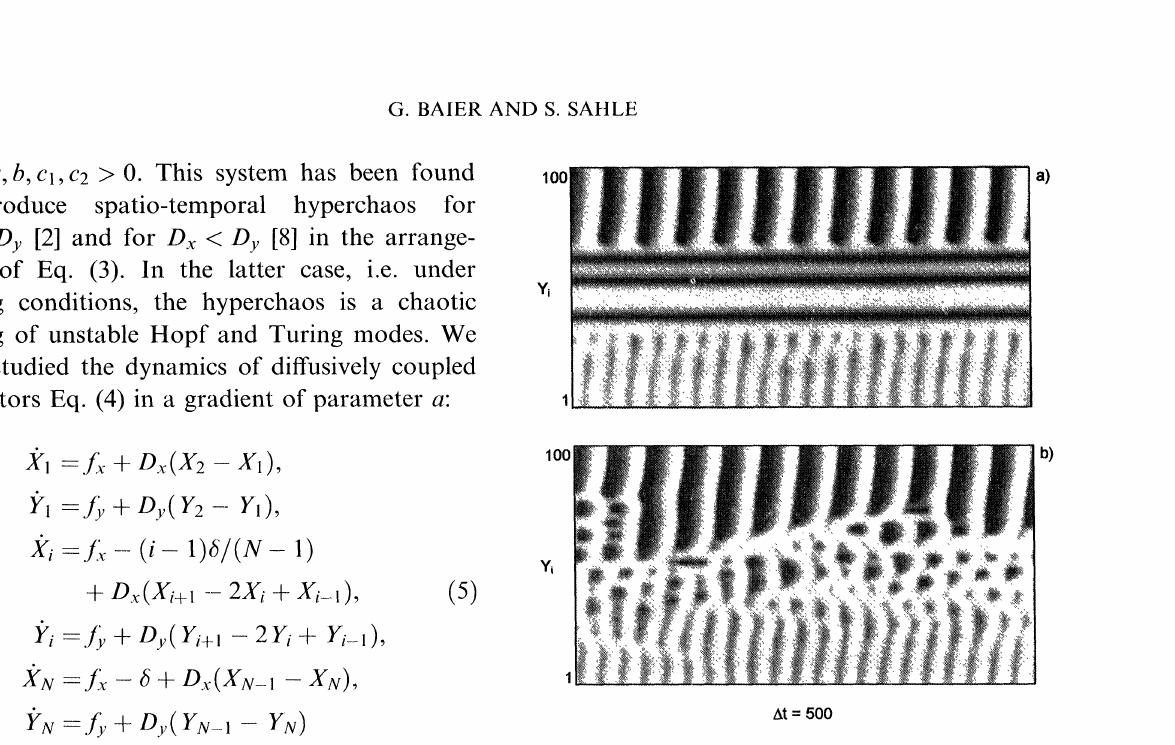
FIGURE 3 Spatio-temporal evolution of 100 oscillators Eq. (4) coupled in the form of Eq. (5) with a--0.057, b---0.12, c 0.5, c2 0.1,